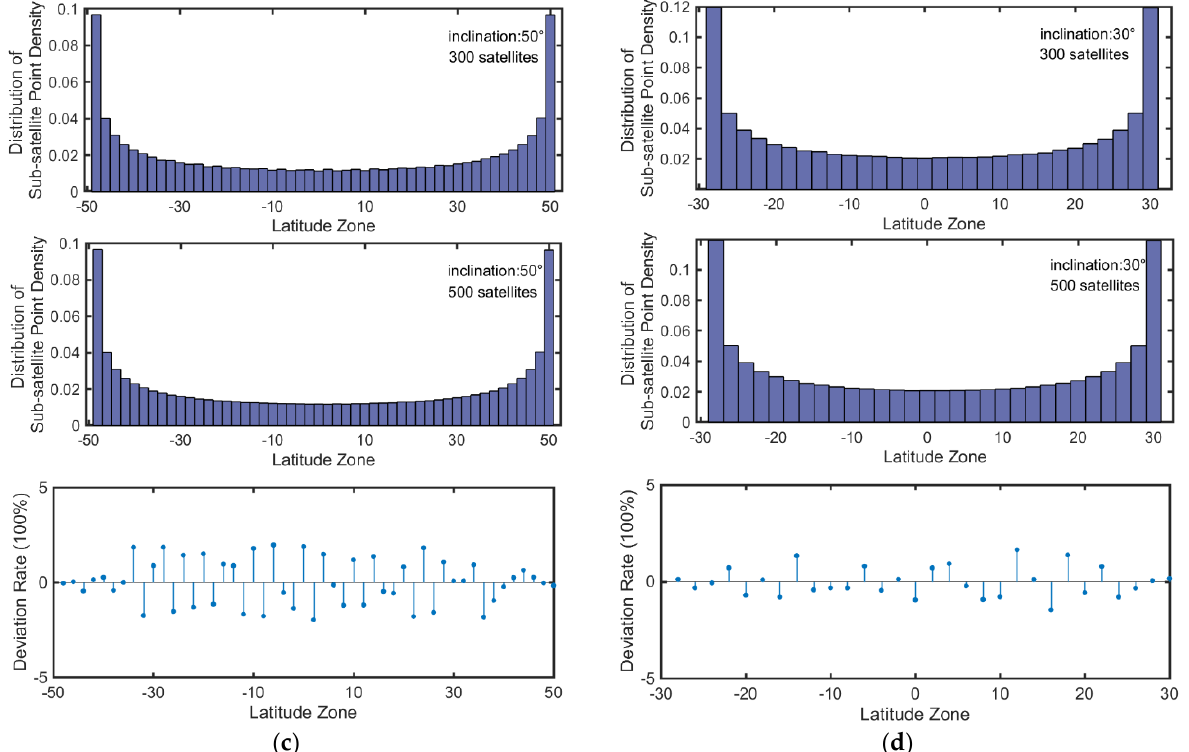
Figure 6. Distribution of sub-satellite points density along latitude zones with the variation of the total number of satellites and the orbital inclination. ( a ) Constellation with an orbital inclination of 90°; ( b ) Constellation with an orbital inclination of 70°; ( c ) Constellation with an orbital inclination of 50°; ( d ) Constellation with an orbital inclination of 30°.